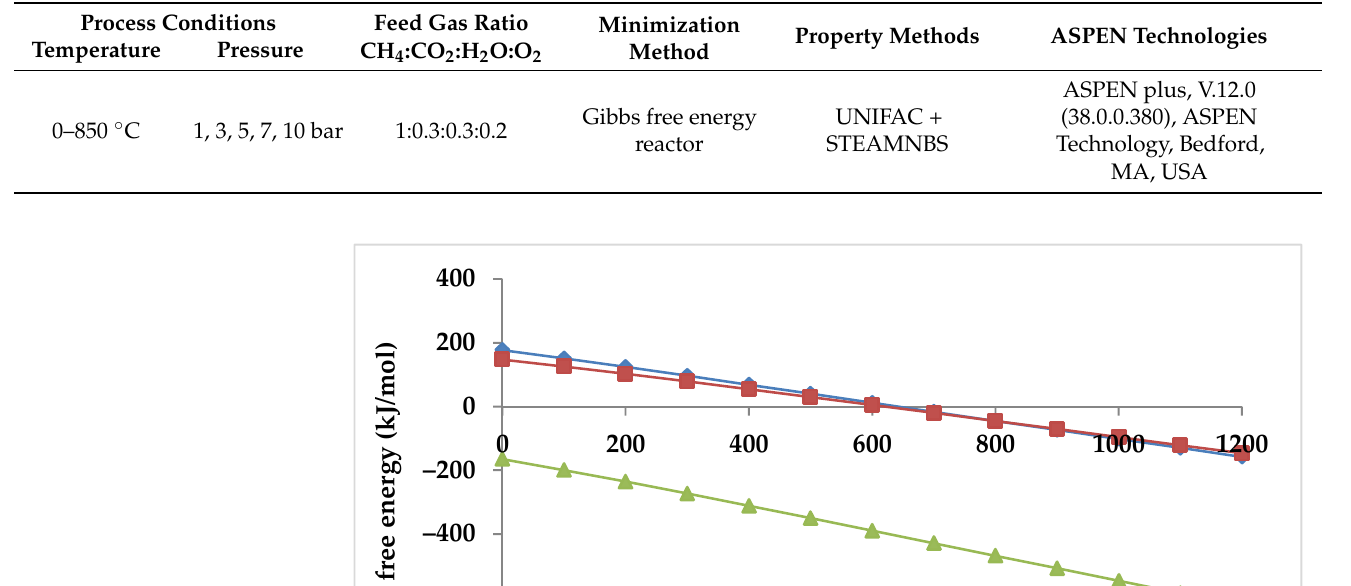
Table 2. Simulation settings and conditions considered for Figures 7 and 8.